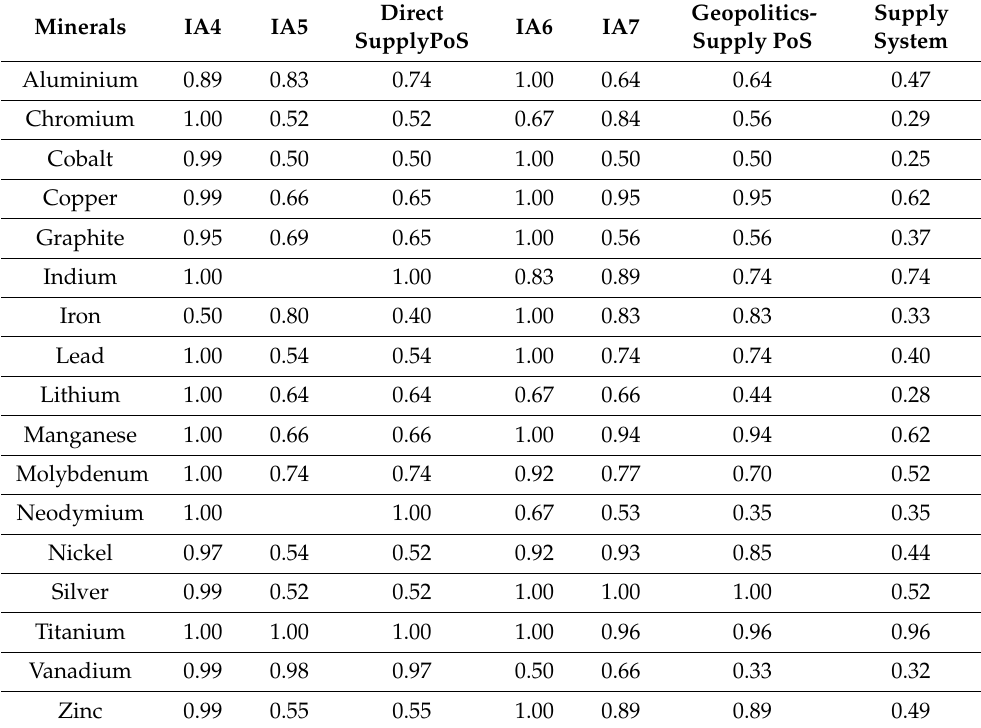
Table 6. Result of calculation of intermediate levels of supply system in Scenario 2 fuzzy